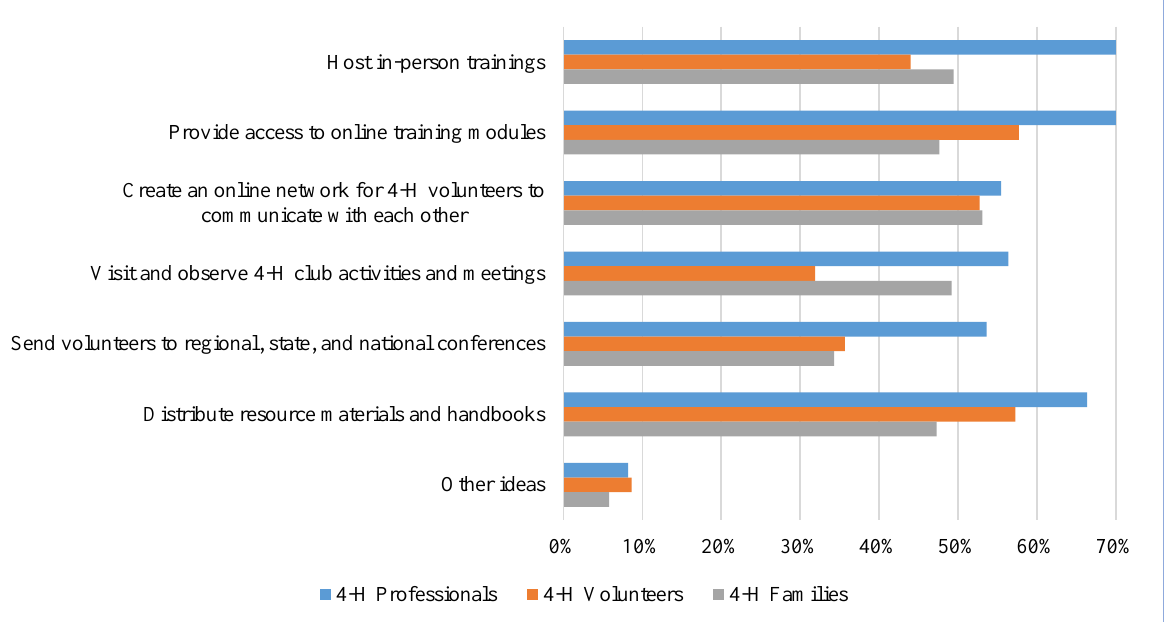
Figure 2. Percentage of Respondents Indicating Which Approaches Should be Used to Better Equip 4-H Volunteers with Desired Knowledge, Skills, and